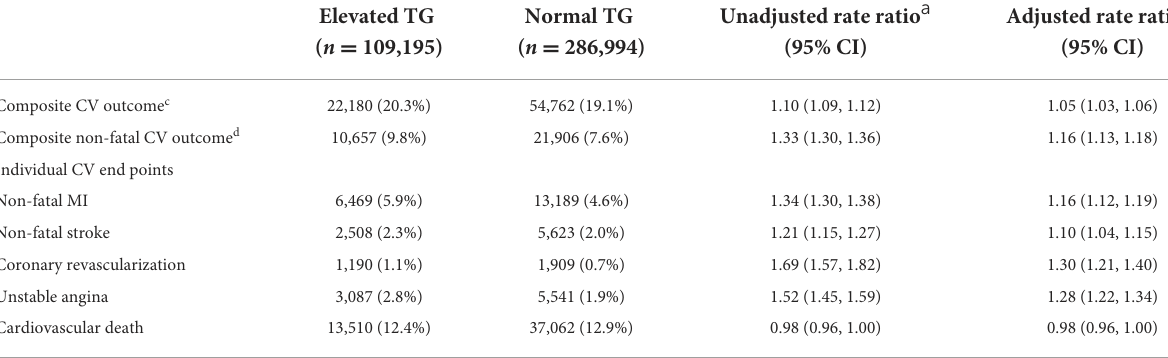
TABLE 3 Crude prevalence, crude and adjusted rate ratios for elevated vs. normal TG comparisons of cardiovascular outcomes.